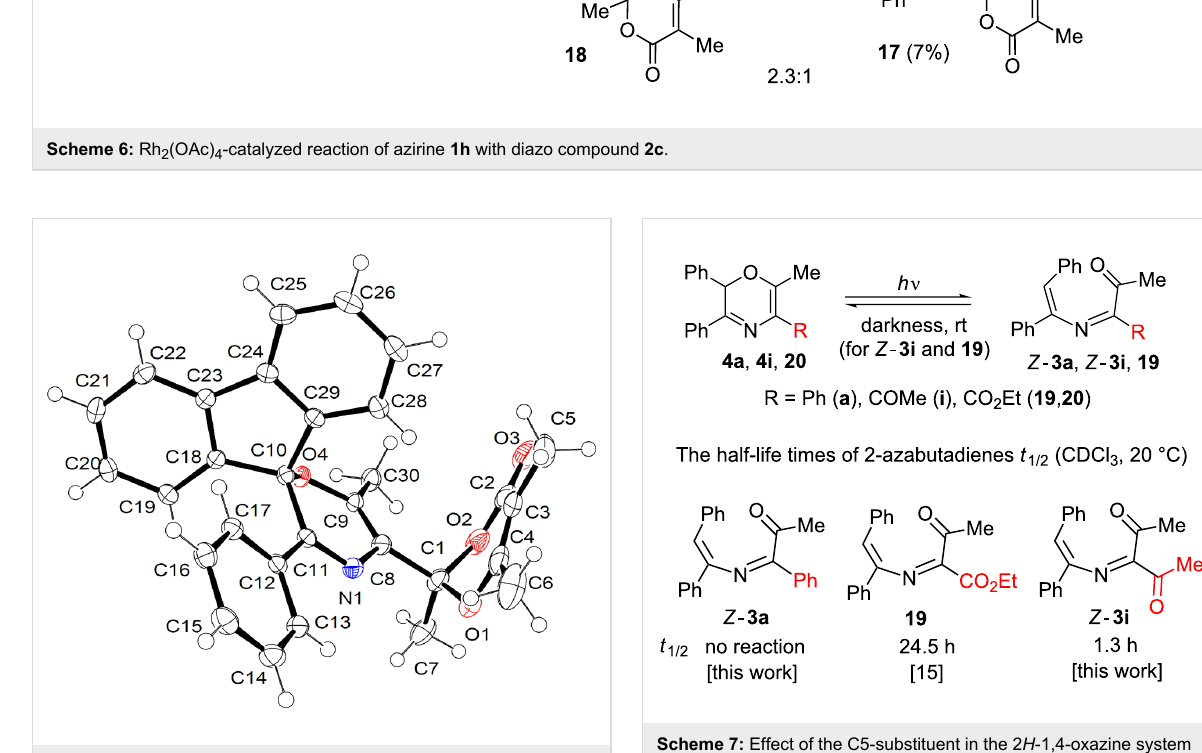
Figure 4: X-ray crystal structure of compound 17 .